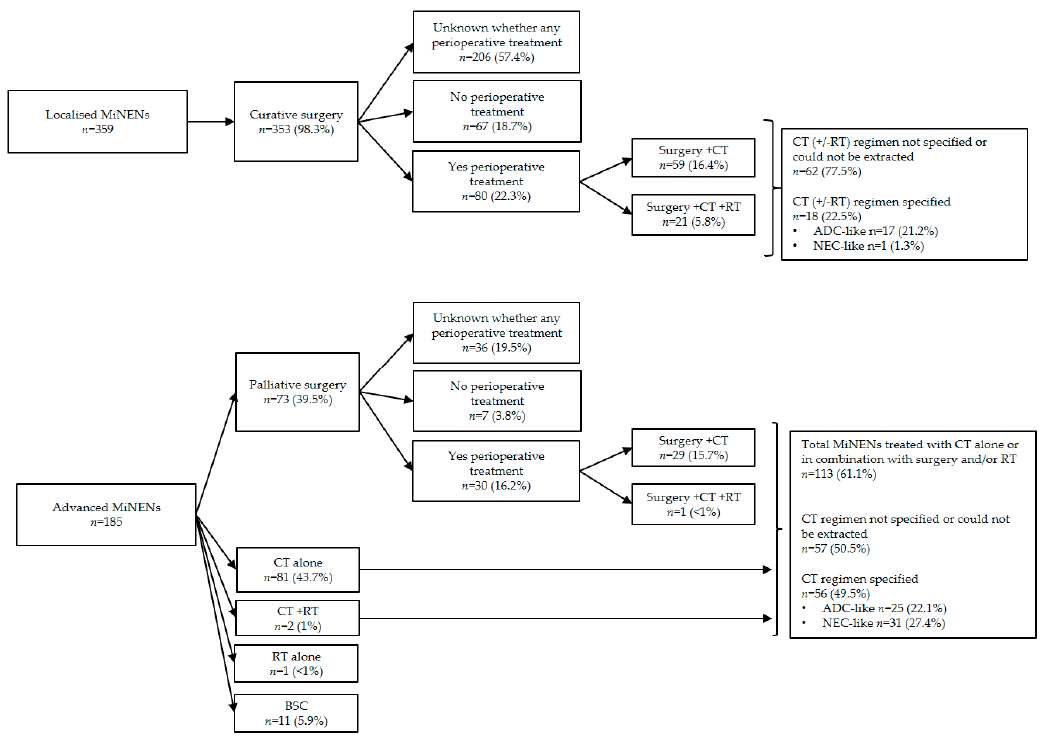
Figure 2. Treatment modalities of MiNEN in retrospective studies. MiNEN = mixed neuroendocrine non-neuroendocrine neoplasm; n = number of patients; CT = chemotherapy; RT = radiotherapy; BSC = best supportive care; peri operative = pre surgical and / or post-surgical; ADC-like = in keeping with standard of care for pure adenocarcinomas from the same sites of origin; NEC-like = in keeping with standard of care for pure neuroendocrine carcinomas.